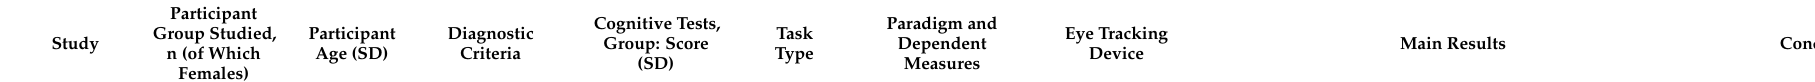
Table A2. A full breakdown of the methodology and subsequent results of each study included in this